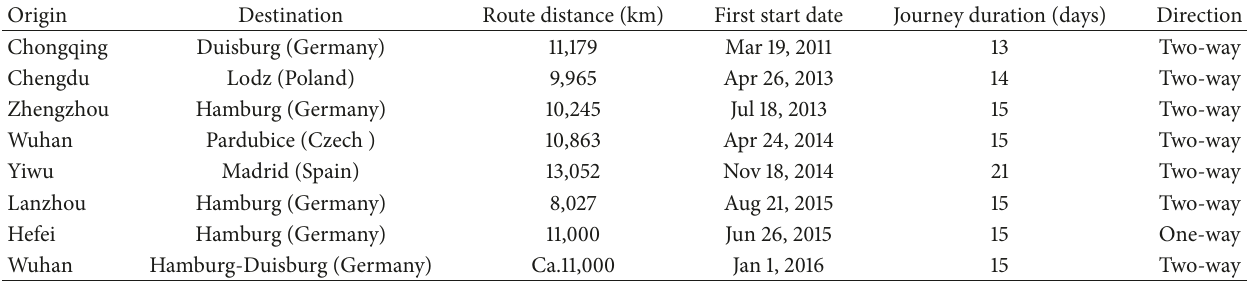
Table1:Major“CRexpresses”(viaXinjiang(Alashankouhub))(source:author,adaptedfrom[1] and news from https://www.yidaiyilu.gov.cn/).